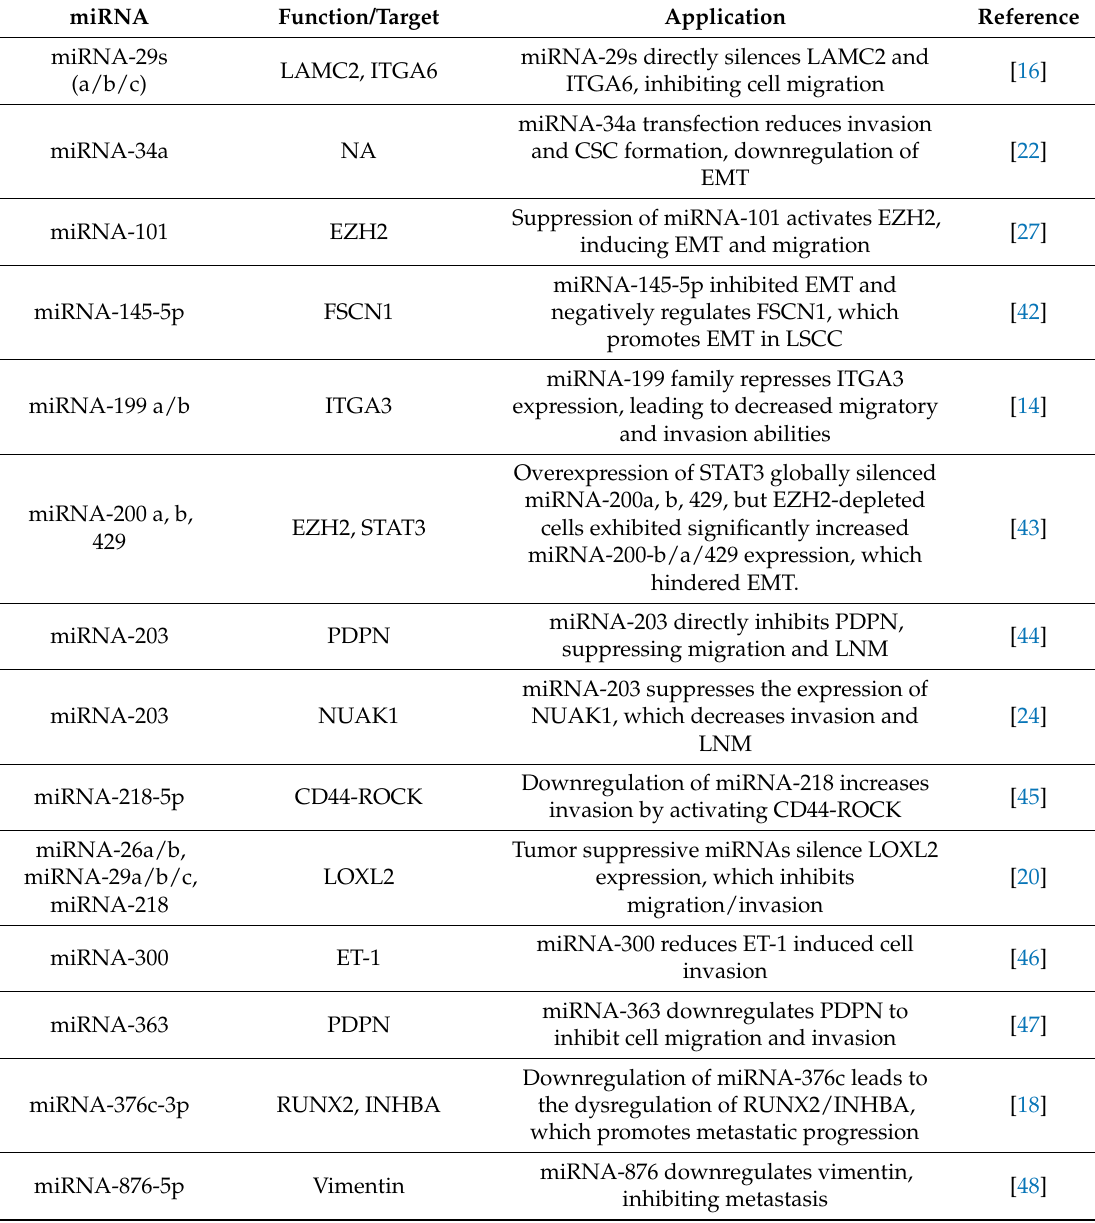
Table 2. miRNAs that suppress HNSCC